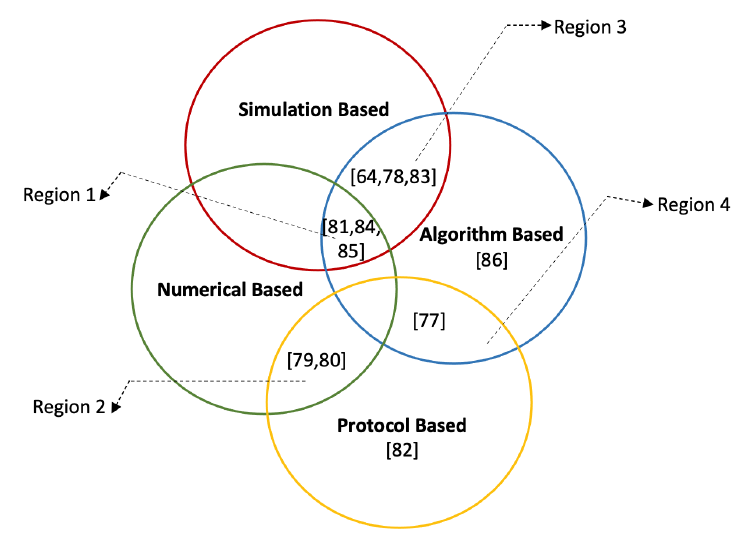
Figure 8. Classification of solution approaches for leader